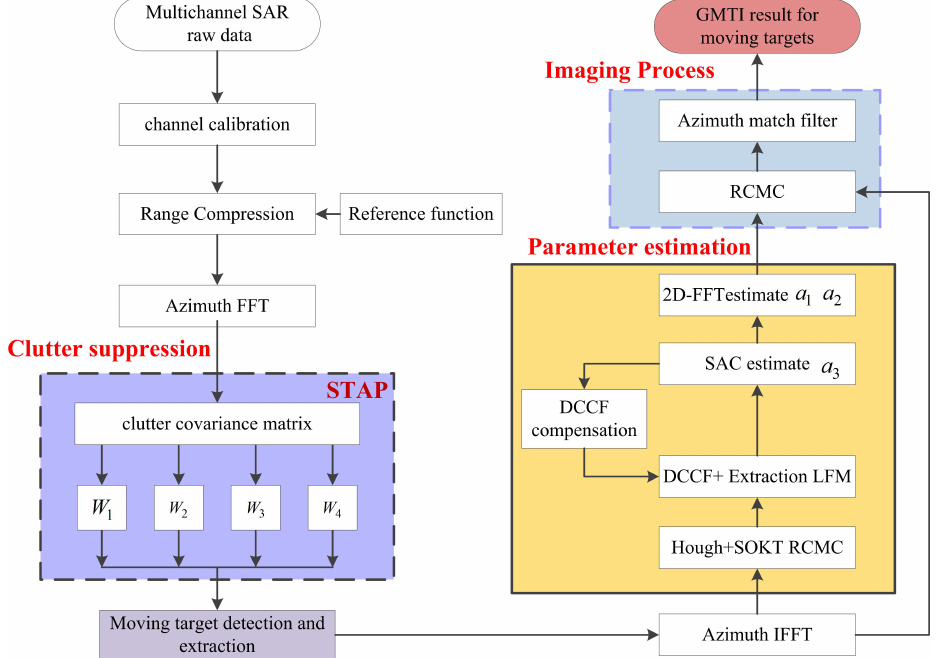
Figure 4. The flowchart of the proposed